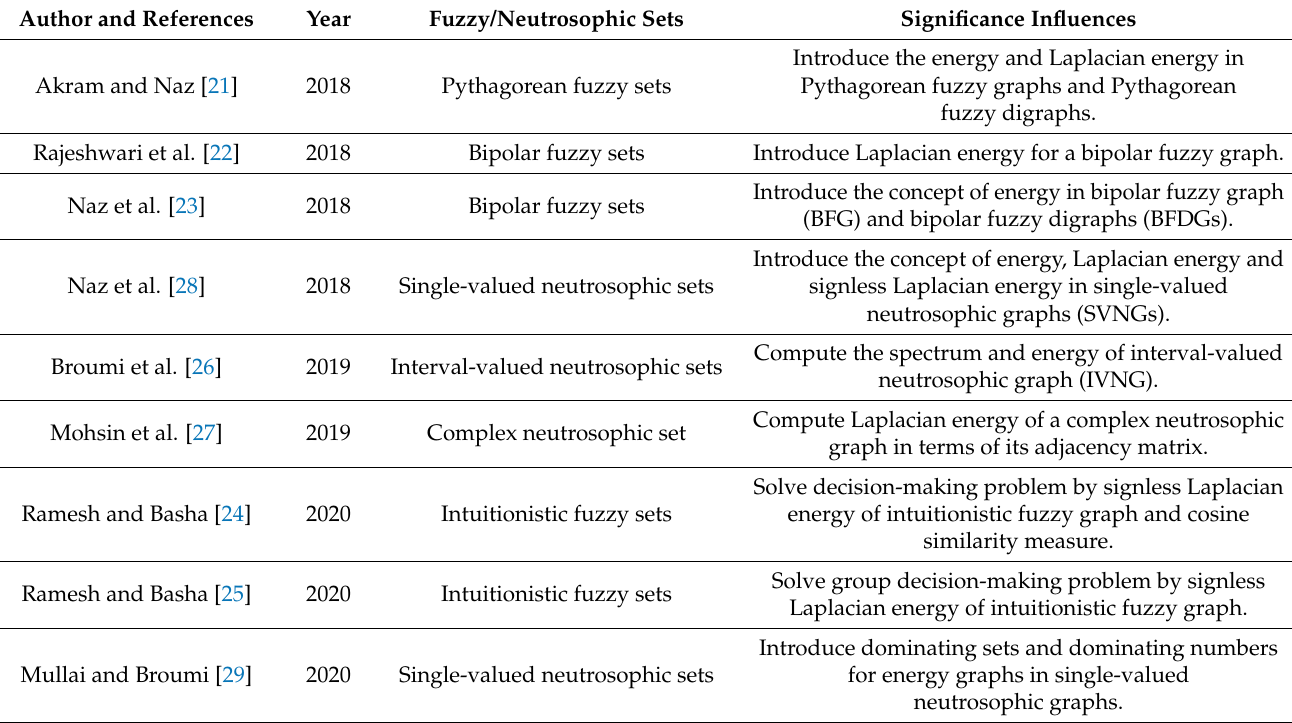
Table 1. Significance influences towards energy, Laplacian energy and signless Laplacian energy graph. Significance Influences Introduce the energy and Laplacian energy in Pythagorean fuzzy graphs and Pythagorean fuzzy digraphs. Introduce Laplacian energy for a bipolar fuzzy graph. Introduce the concept of energy in bipolar fuzzy graph Bipolar fuzzy sets (BFG) and bipolar fuzzy digraphs (BFDGs). Introduce the concept of energy, Laplacian energy and signless Laplacian energy in single-valued neutrosophic graphs (SVNGs). neutrosophic graph (IVNG). graph in terms of its adjacency